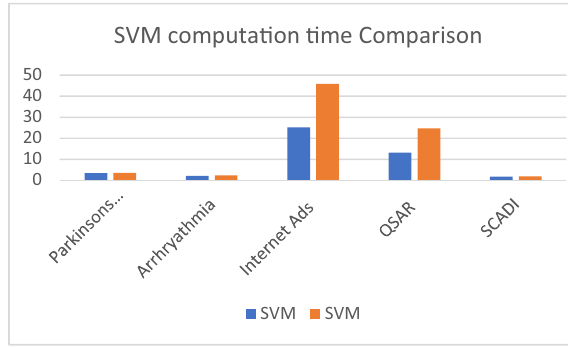
Figure 6: Comparison of the execution time of FrbyCC and PCA with SVM classi fi